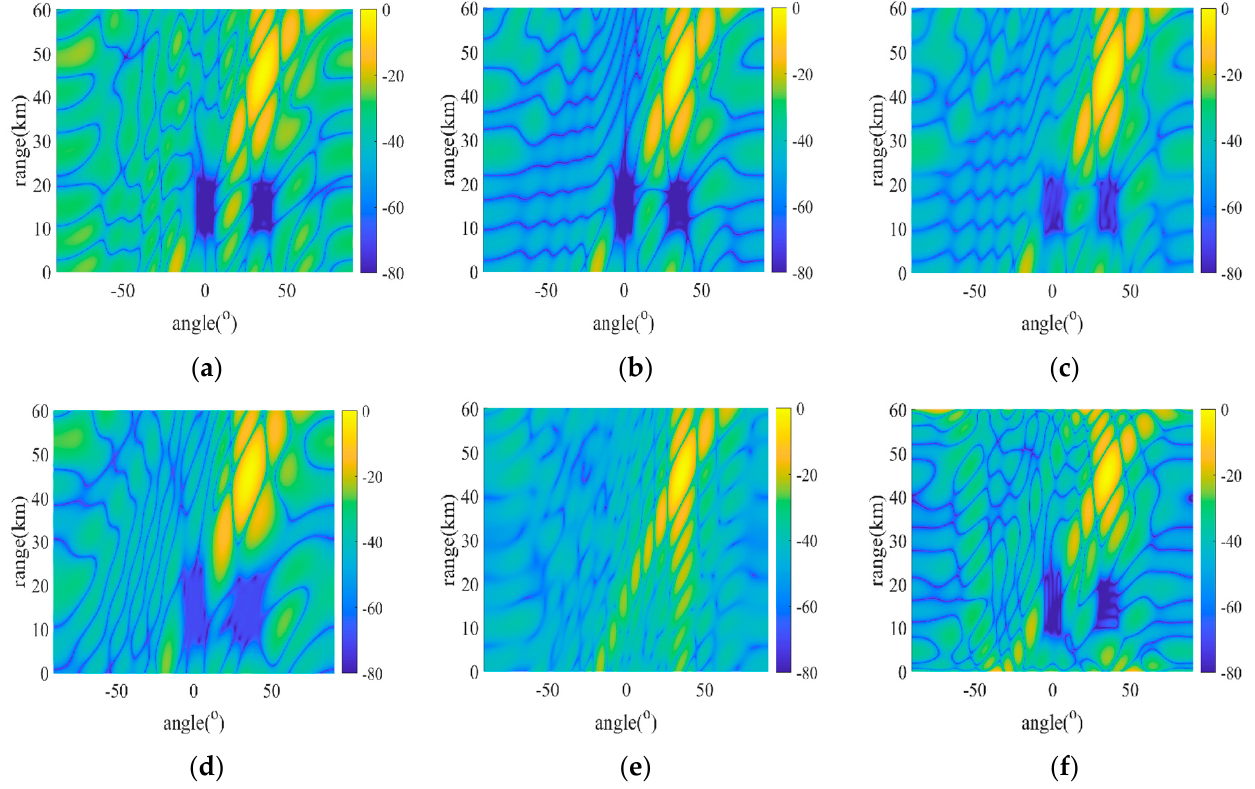
Figure 7. Two–dimensional beampattern of different methods when the swarm interference is distributed in two areas. ( a ) CMC, ( b ) CMD, ( c ) SNBC, ( d ) CNBC, ( e ) SMI-MVDR, and ( f ) INCMR–LCSS.